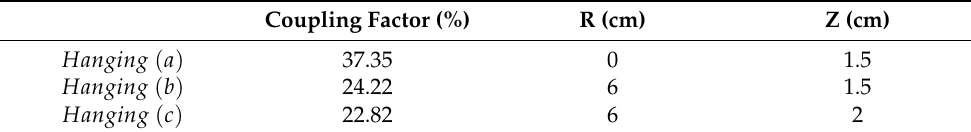
Table 3. Measured coupling factor of different hanging scenarios.